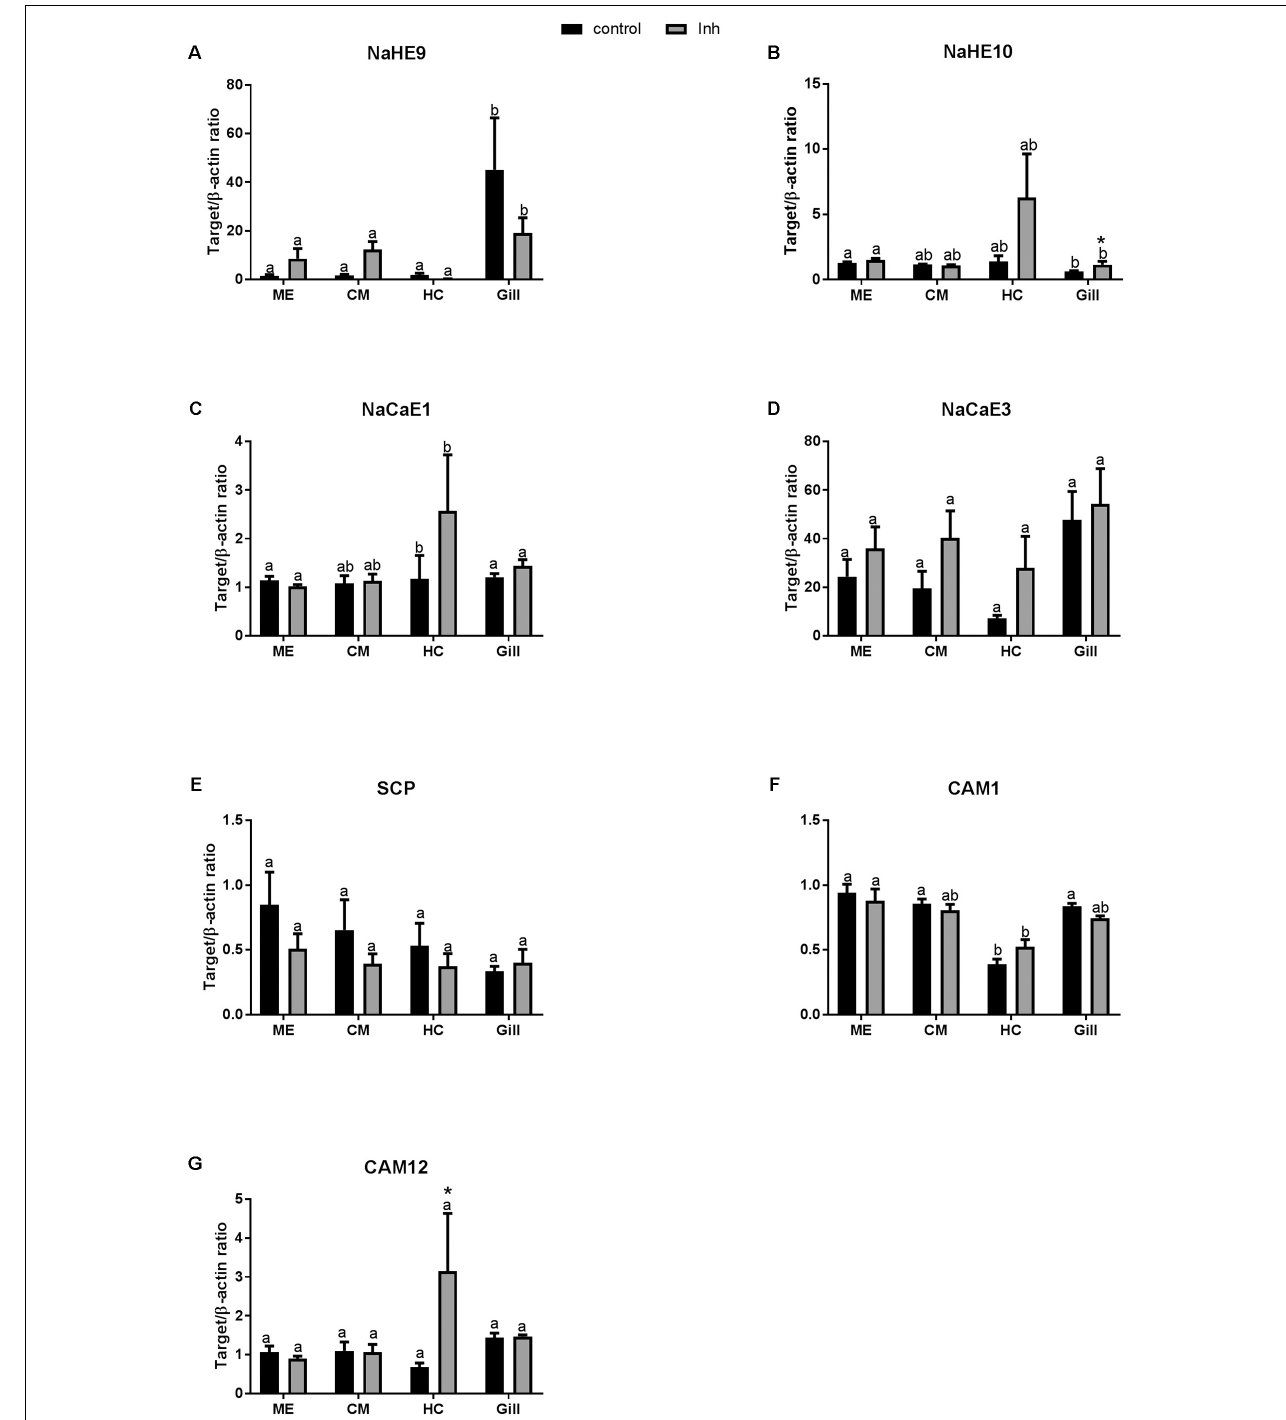
FIGURE 4 | Levels of mRNA expression of ion transporters and Ca binding proteins in tissues of adult C. gigas in response to a 2-week axitinib exposure. Genes: (A,B) NaHE9 and NaHE10 – Na + /H + exchangers 9 and 10, respectively; (C,D) NaCaE1 and NaCaE3 – Na + /Ca 2 + exchangers 1 and 3, respectively; (E) SCP – sarcoplasmic calcium-binding protein; (F,G) CAM 1 and CAM 12 – calmodulin 1 and 12, respectively. Control – control oysters and Inh – axitinib-exposed oysters. Expression levels in the mantle edge (ME), central mantle (CM), hemocytes (HC), and the gills (Gill) are shown. Different letters indicate significant differences between different tissues under the same treatment conditions (i.e., control or axitinib exposure); columns that do not share a letter are significantly different ( p < 0.05). Asterisks indicate significant differences between the control and axitinib-exposed oysters in the same tissue. N = 3–5.